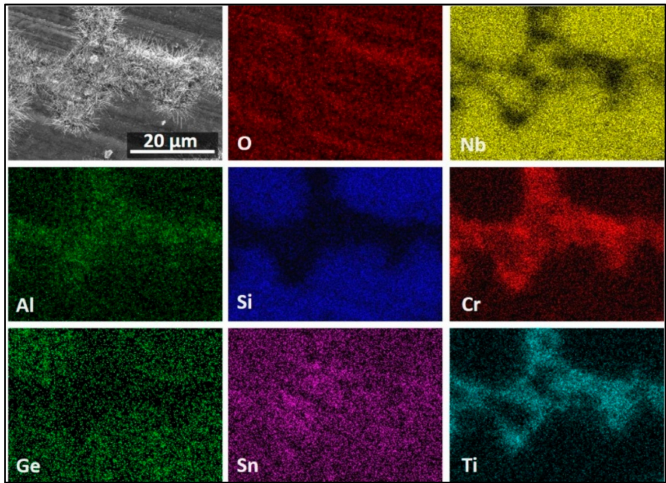
Figure 7. SE image and X-ray elemental maps of the scale surface of the alloy OHS1 after isothermal oxidation in air at 800 ◦